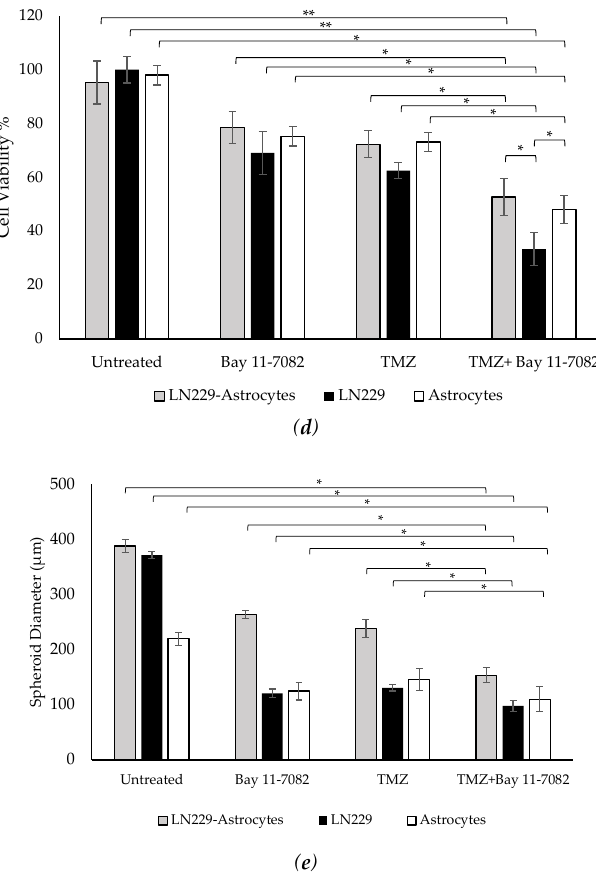
Figure 2. Representative images of co ‐ cultured and mono ‐ cultured cells in the PEGDA microwells (400 μ m) after 7 days of drug administrations: untreated, Bay 11 ‐ 7082, Temozolomide (TMZ), and TMZ–Bay 11 ‐ 7082. Effects of the drug treatment on both co ‐ culture and mono ‐ culture were visualized by the disaggregation of the dead cells on day 7. LN229 and astrocytes cells were stained with cell tracker red and cell tracker green, respectively. ( a ) LN229–astrocytes (1:1) co ‐ culture. ( b ) LN229 mono ‐ culture. ( c ) Astrocytes mono ‐ culture. ( d ) Viability of co ‐ cultured and mono ‐ cultured cells. ( e ) Diameter of co ‐ cultured and mono ‐ cultured spheroids ( μ m). * indicates p < 0.05, ** indicates p < 0.01. X20 objective. Scale bars, 100 μ m.